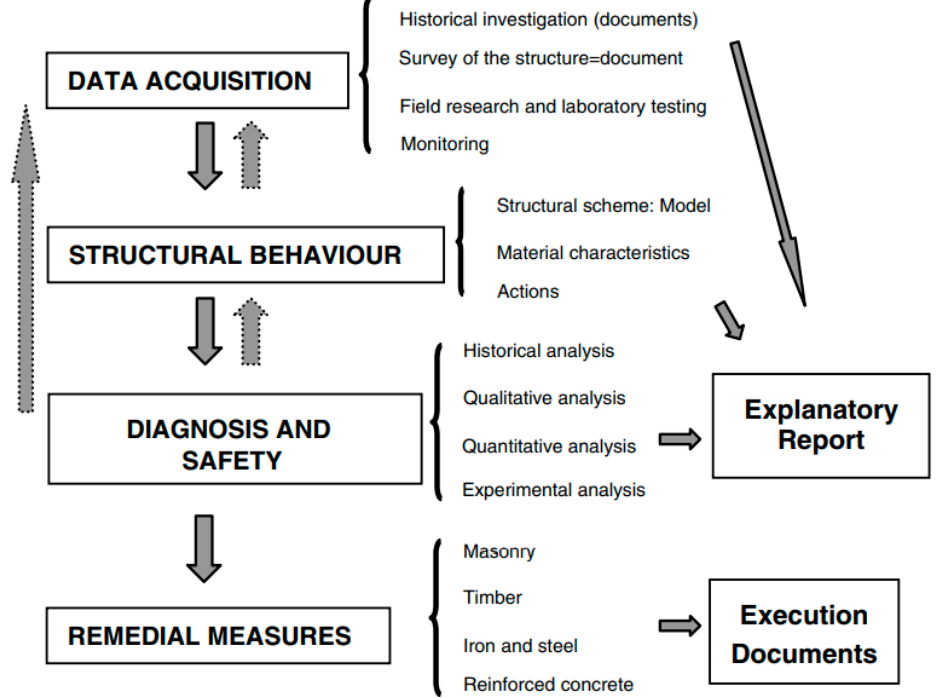
Figure 2. Flowchart with the methodology for structural interventions proposed by [16,19]. Repro- duced with permission from Lourenço, P.B., 2022.